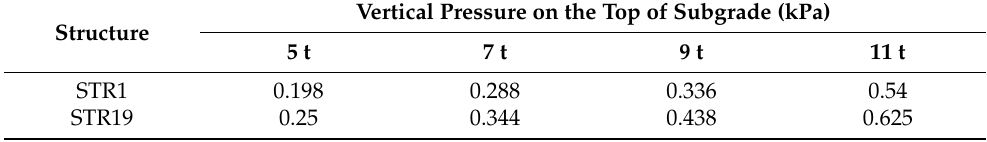
Table 9. The measured vertical